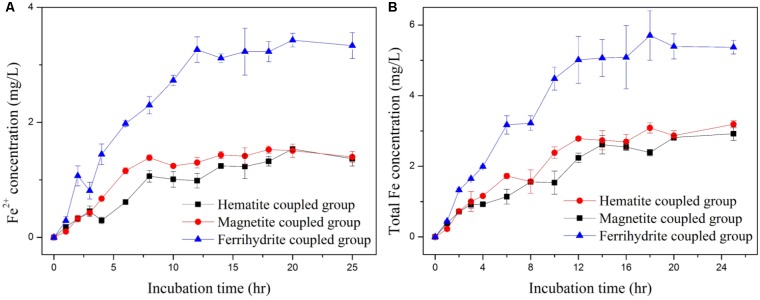
Profiles of Fe2+ concentration (A) and total Fe concentration (B).